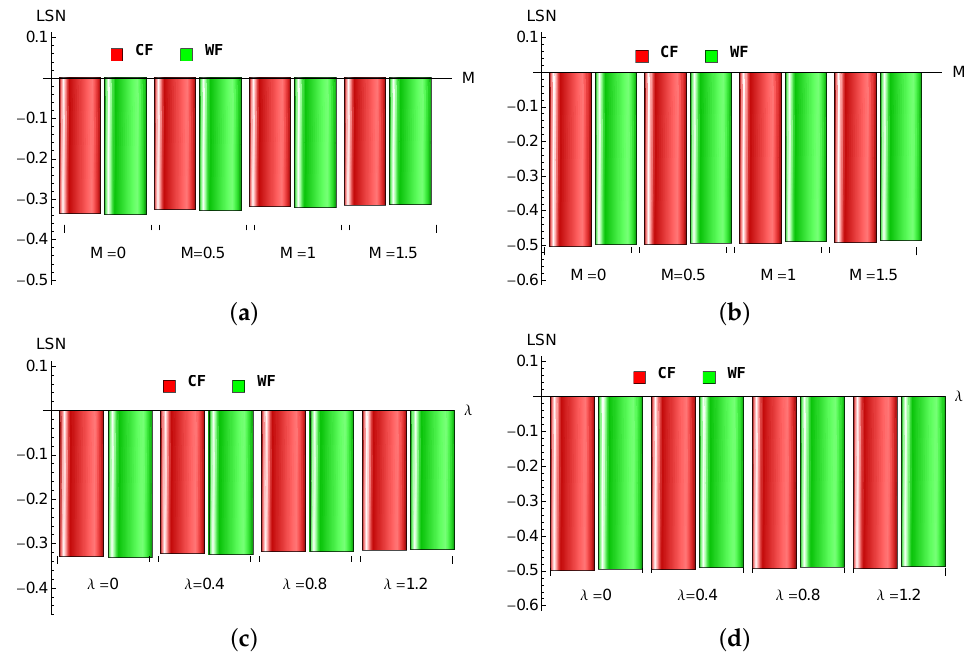
Figure 7. The local Sherwood number (LSN) for different values of M with fw = − 0.6 ( a ), M with fw = 0.6 ( b ), λ with fw = − 0.6 ( c ) and λ with fw = 0.6 ( d ) for Casson nanofluid (CF) and Williamson nanofluid